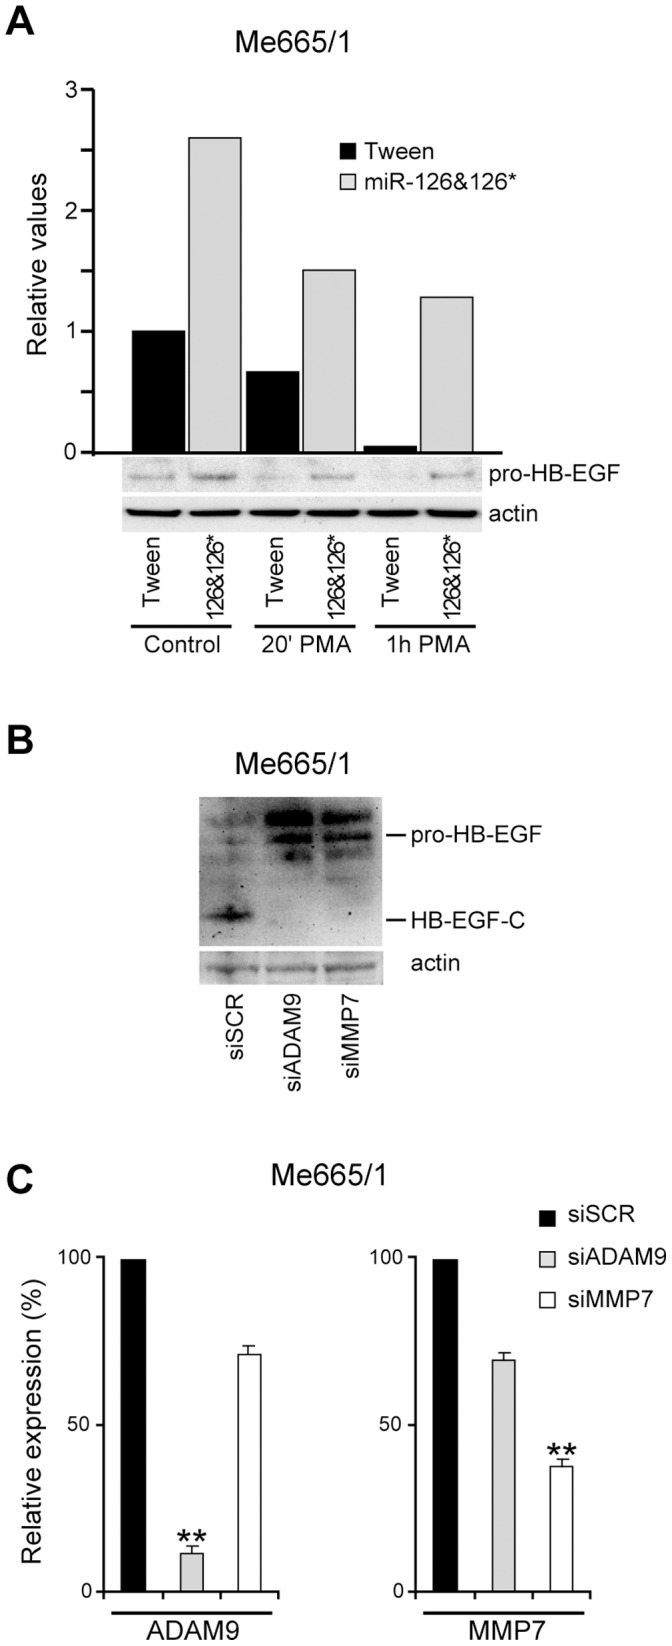
HB-EGF regulation in miR-126&126*-transduced cells.Representative WB of A) pro-HB-EGF (bottom) and relative densitometric analysis (top) in miR-126&126*- versus empty vector-transduced Me665/1 melanoma cell line treated or not with PMA. B) pro-HB-EGF and HB-EGF-C levels in si-ADAM9- or si-MMP7-infected melanoma compared with si-scrambled control. C) Real time PCR analysis of ADAM9 and MMP7 in the same silenced cells.